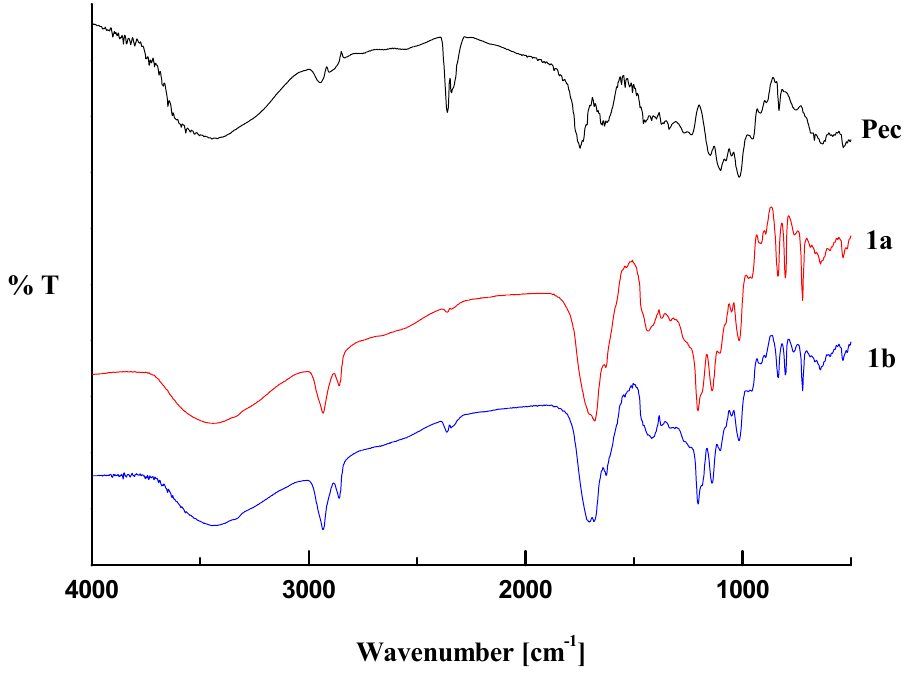
Figure 1. Transmittance FT-IR spectra pectin-linoleate ( 1 ) and pectin.